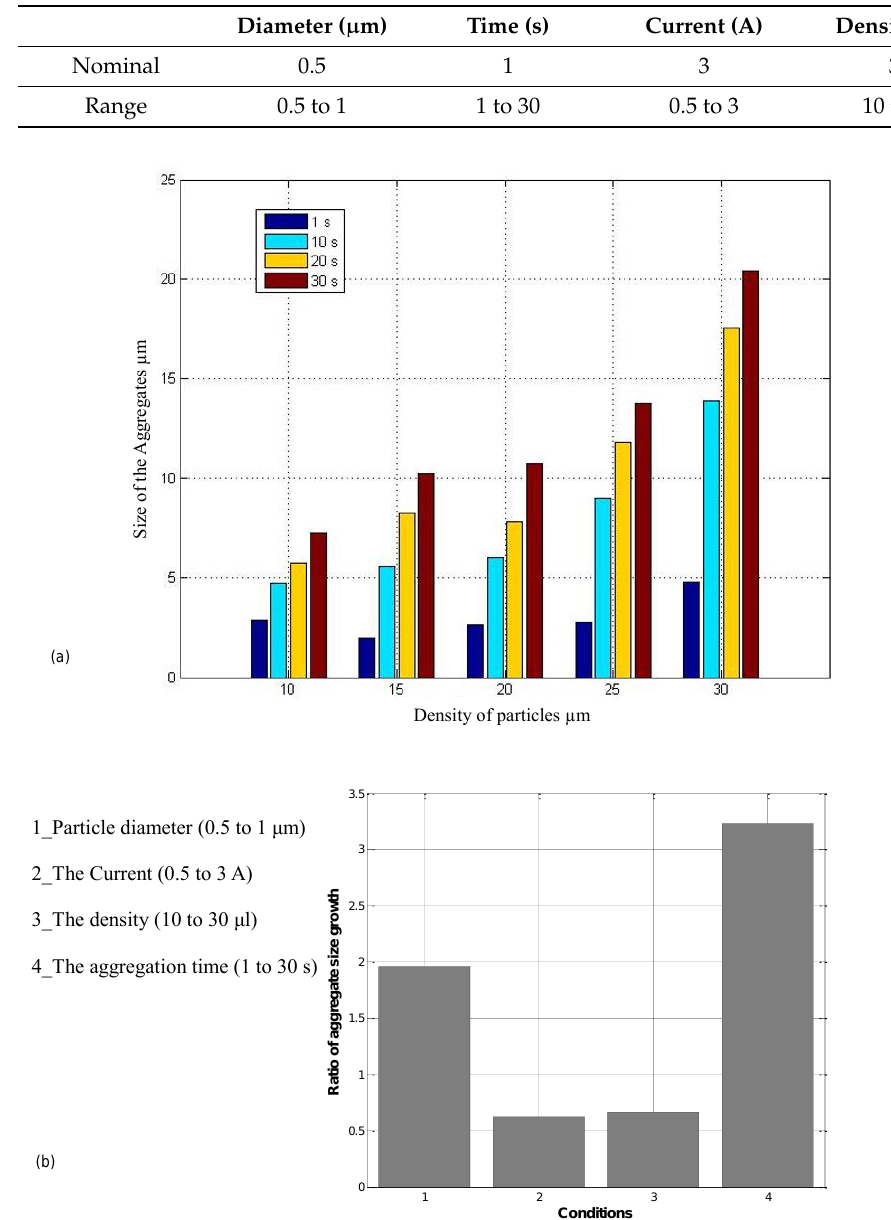
Figure 9. ( a ) Diagram of the aggregation time and particle density (mean value for n = 3 with less than 5% variation); ( b ) normalized aggregation rate to show the effect of particle diameter, the electromagnets’ current (representing the magnetic field), the particle density, and the aggregation time (the nominal aggregation length based on Table 5 values is 6.2 µ